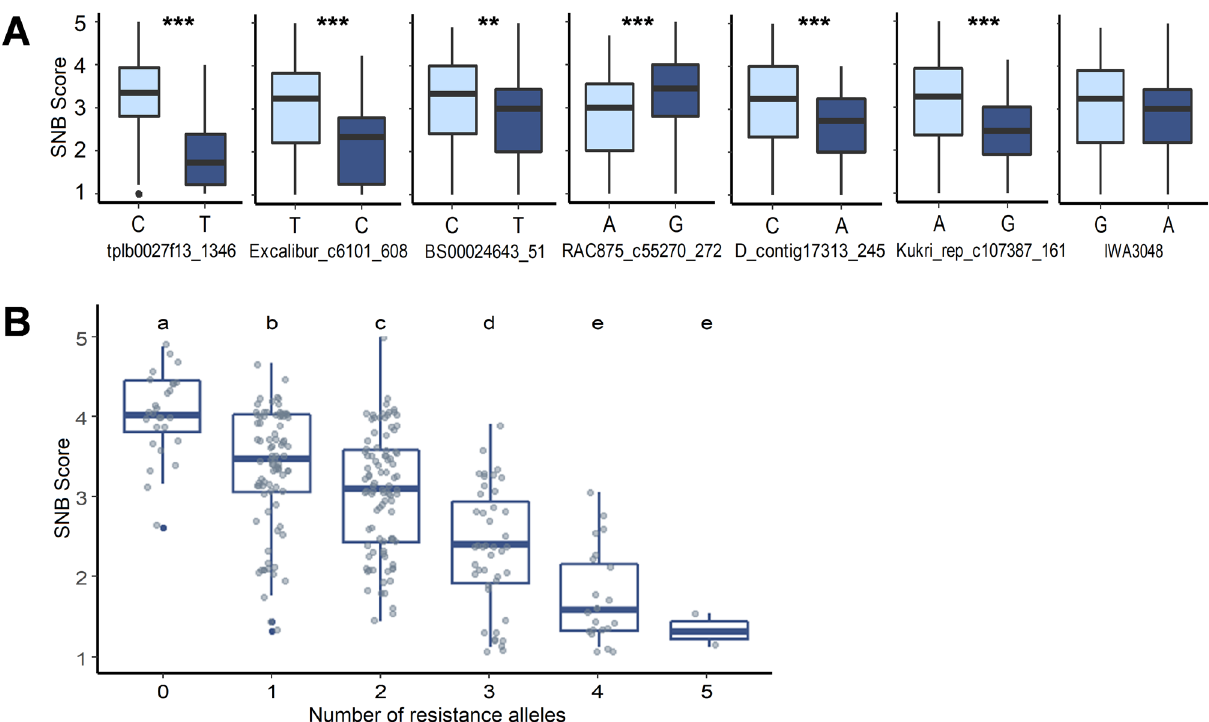
Figure 4. ( A) Pairwise comparison for SNB score among two alleles of the seven significant MTAs identified for SNB resistance on chromosomes 5BL, 7AL, 2AL, 6BS, 2DS, 4AL, and 1B, respectively (enlisted in Table 2). A t-test was used to compare the two groups. Two asterisks denote significant difference at ( P < 0.01 ) and three asterisks denote significant difference at ( P < 0.001 ). (B) Effect of accumulation of resistant alleles for the detected associations on SNB disease score. The different groups were compared using FDR corrected pairwise t-test. Levels denoted by different letters are significantly different ( P < 0.05